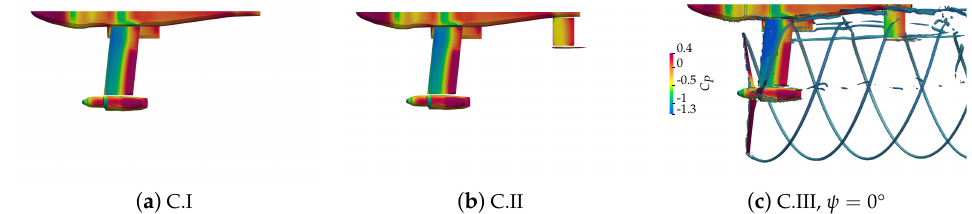
Figure 21. Coupled simulation results for the three configurations at bank angle φ = 30°: pressure coefficient C P contours over the aircraft surface for the three configurations and iso-surface of Q-Criterion ( Q = 1200) for flow field description for